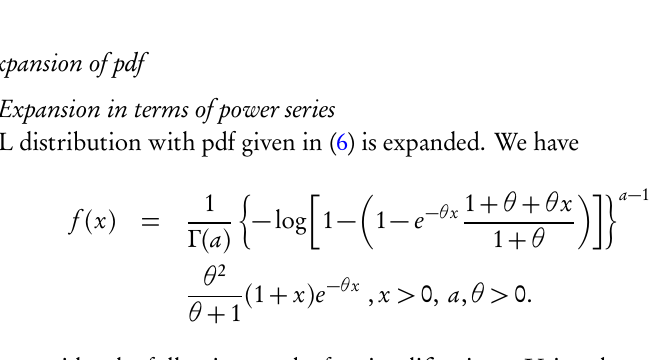
Figure 1 – The pdf of ZBL distribution is plotted for different values of a and θ